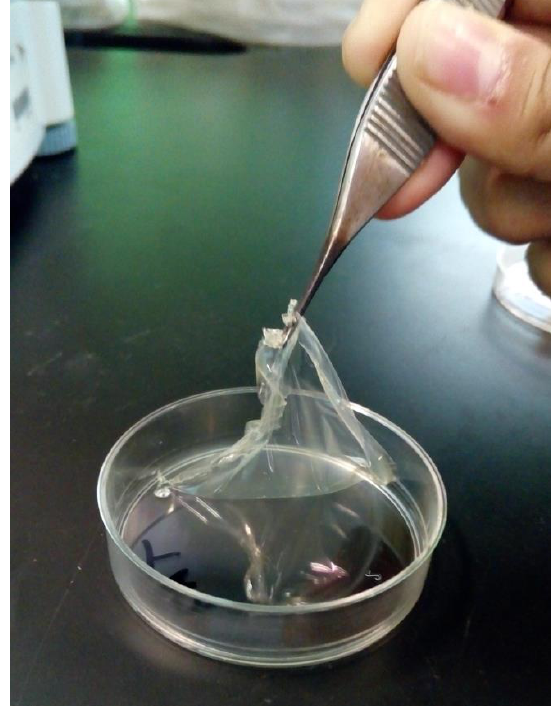
Figure 6. Freshly made films from T3 formulation containing L. paracasei TEP6 cells.